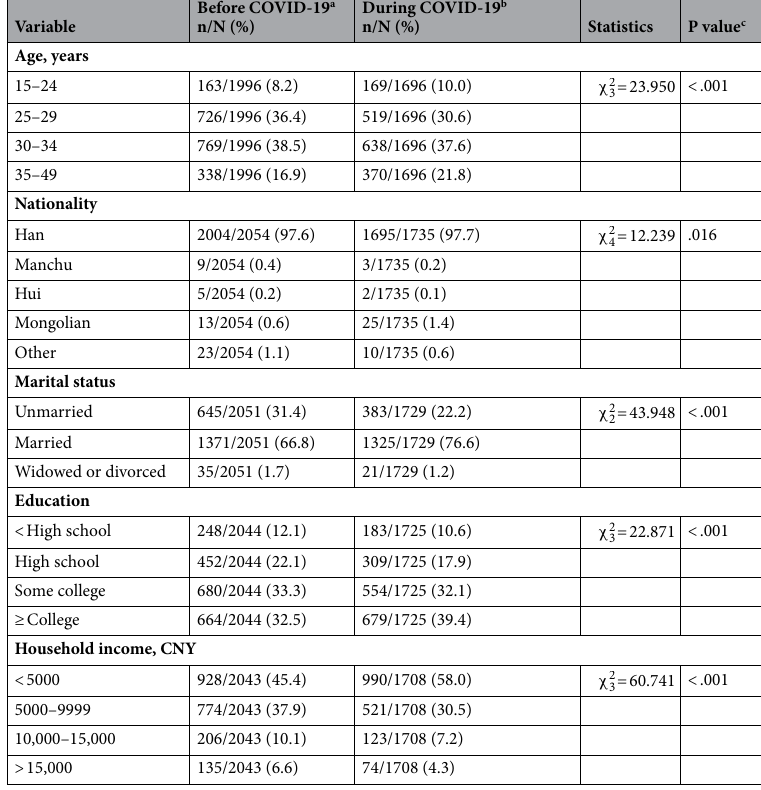
Table 1. Demographic characteristics of samples before and during COVID-19 lockdown. a n = number who answered the question; denominator is not always 2054 because of missing data. b n = number who answered the question; denominator is not always 1735 because of missing data. c Two-tailed χ 2 analysis conducted for significance